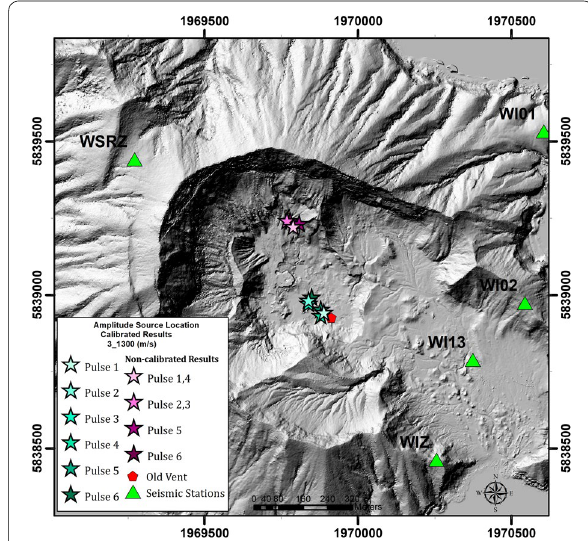
Fig. 8 Calibrated amplitude source location results for each eruption pulse. Input values of a quality factor of Q 3 and a body = wave velocity of β 1300 m/s were used to estimate the locations = of non-calibrated results (pink stars) and active source calibrated locations (green stars)